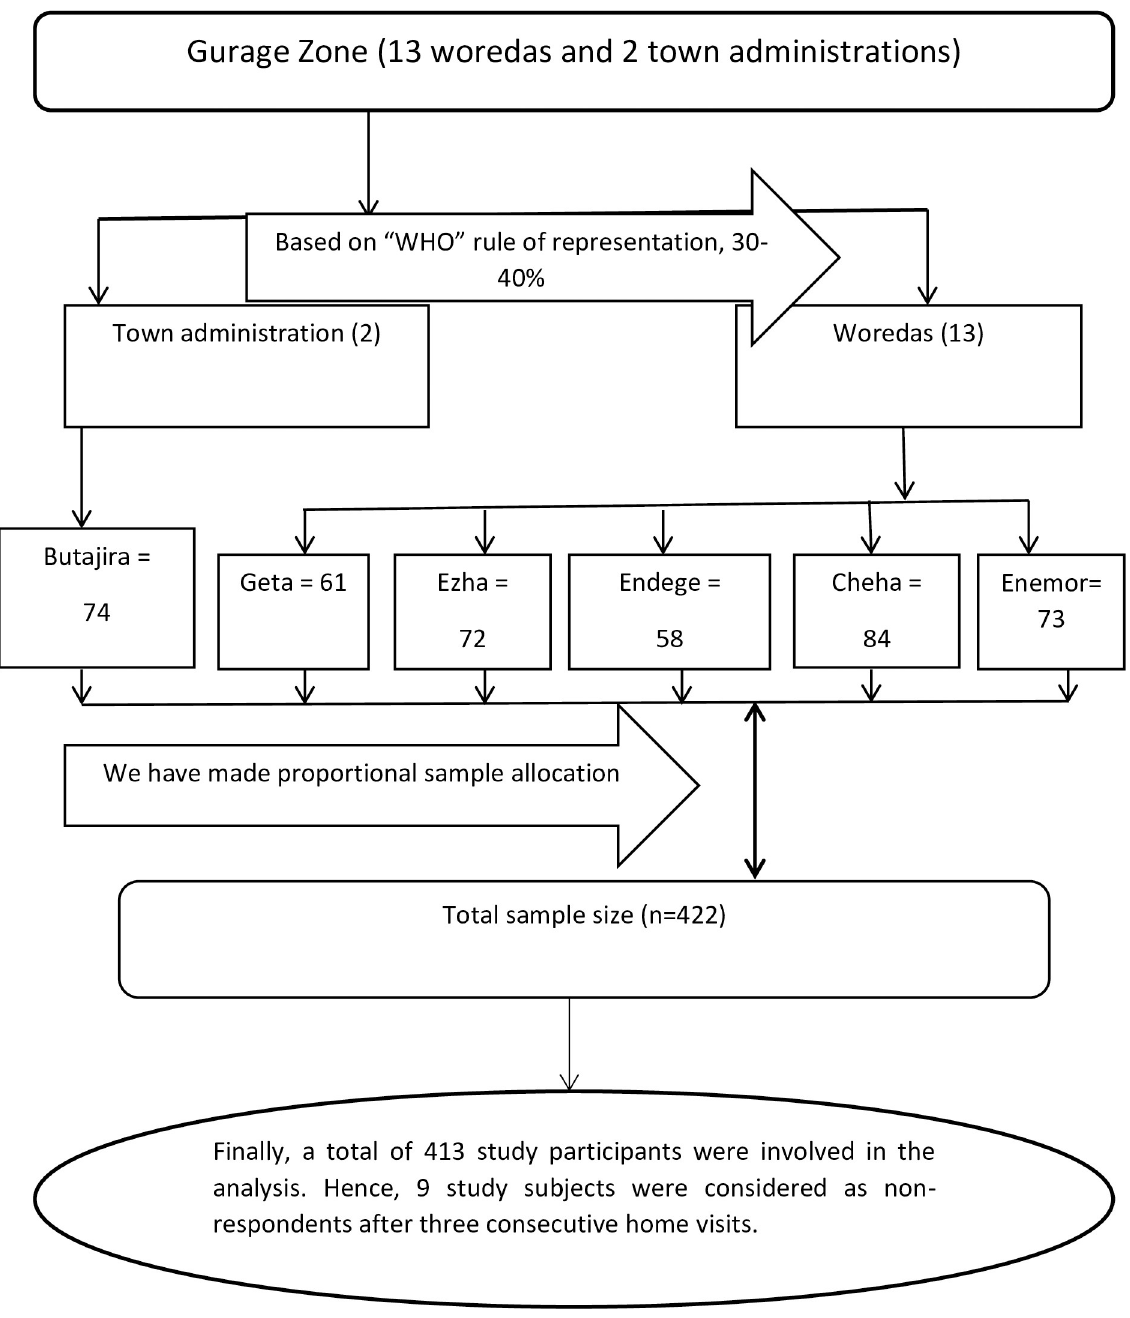
Fig 1. Study flow chart/sampling procedure for a study on harmful cultural practices during pregnancy, childbirth, and postnatal period, and associated factors that clarify the sample enrolled or drop out at each phase in Southern Ethiopia, 2019. https://doi.org/10.1371/journal.pone.0254095.g001 ◾ Food taboos, Avoiding colostrum, Delay initiation of breastfeeding, giving butter and/or water for a newborn(pre-lacteal feeding), Use of " kosso” and Use of “ telba” ◾ Abdominal massage ◾ Cutting umbilical cord by unsterile sharp materials, tie umbilical cord by unclean materials